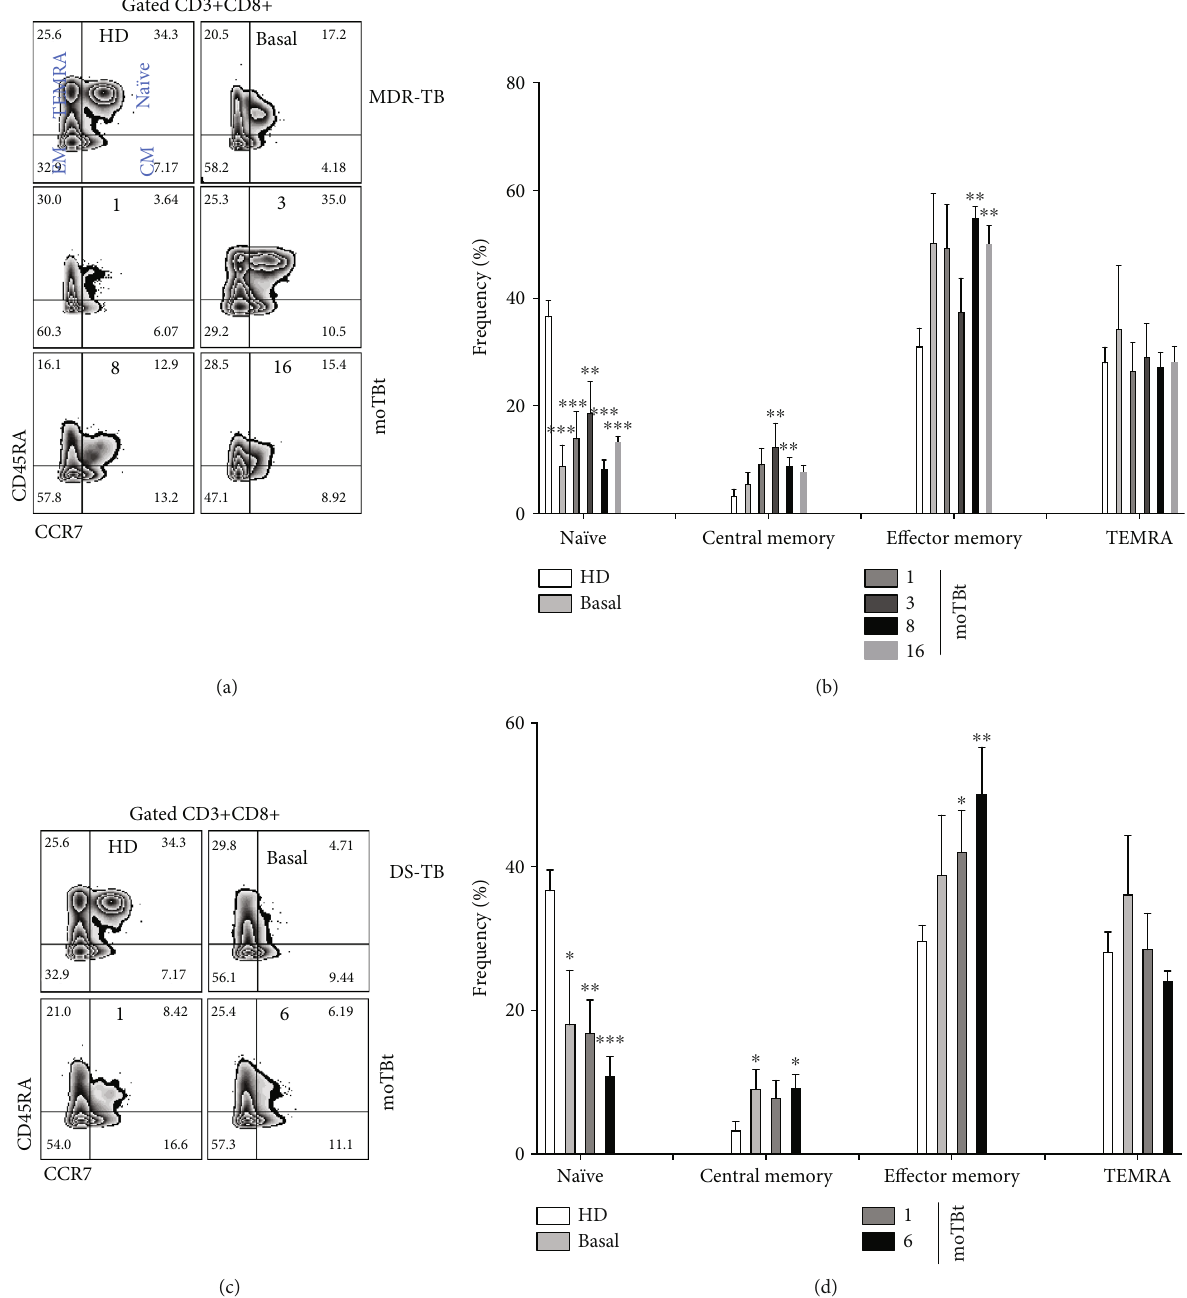
Figure 5: Kinetics of CD8+ T cell subpopulations in MDR-TB patients. Representative zebra plots showing the strategy of analysis used to enumerate naïve (CD45RA+CCR7+), central memory (CM, CD45RA-CCR7+), e ff ector memory (EM, CD45RA-CCR7-), and TEMRA (CD45RA+CCR7-) CD3+CD8+ T cells in peripheral blood mononuclear cells (PBMCs) from multidrug-resistant (MDR-TB) and drug- sensitive (DS-TB) patients (a and c, respectively). (b) Frequency of CD3+CD8+ T cell subpopulations in MDR-TB patients (HD: n = 6 , MDR-TB: basal, 1, and 3 moTBt n = 10 , 8 moTBt n = 8 , and 16 moTBt n = 7 ). (d) Frequency of CD3+CD8+ T cell subpopulations in DS- TB patients (HD n = 6 , DS-TB: basal and 1 moTBt n = 10 , and 6 moTBt n = 8 ). Bar graphs depict means ± standard errorof themean ð SEM Þ . Di ff erences between patient groups and HD at each time point were analyzed using multiple Student ’ s t -test corrected for multiple comparisons using the Sidak – Bonferroni method. ∗ p < 0 : 05 , ∗∗ p < 0 : 01 , ∗∗∗ p < 0 : 001 , and ∗∗∗∗ p < 0 : 0001 . moTBt: months of antituberculosis